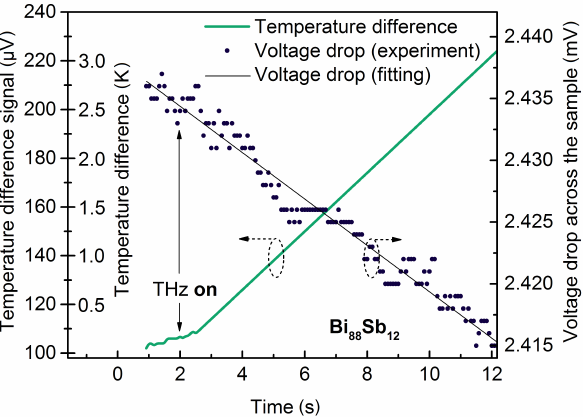
Figure 7. Third experiment (photothermoelectric effect).The temporal dependence of voltage drop in 200 nm Bi 88 Sb 12 films under the influence of THz